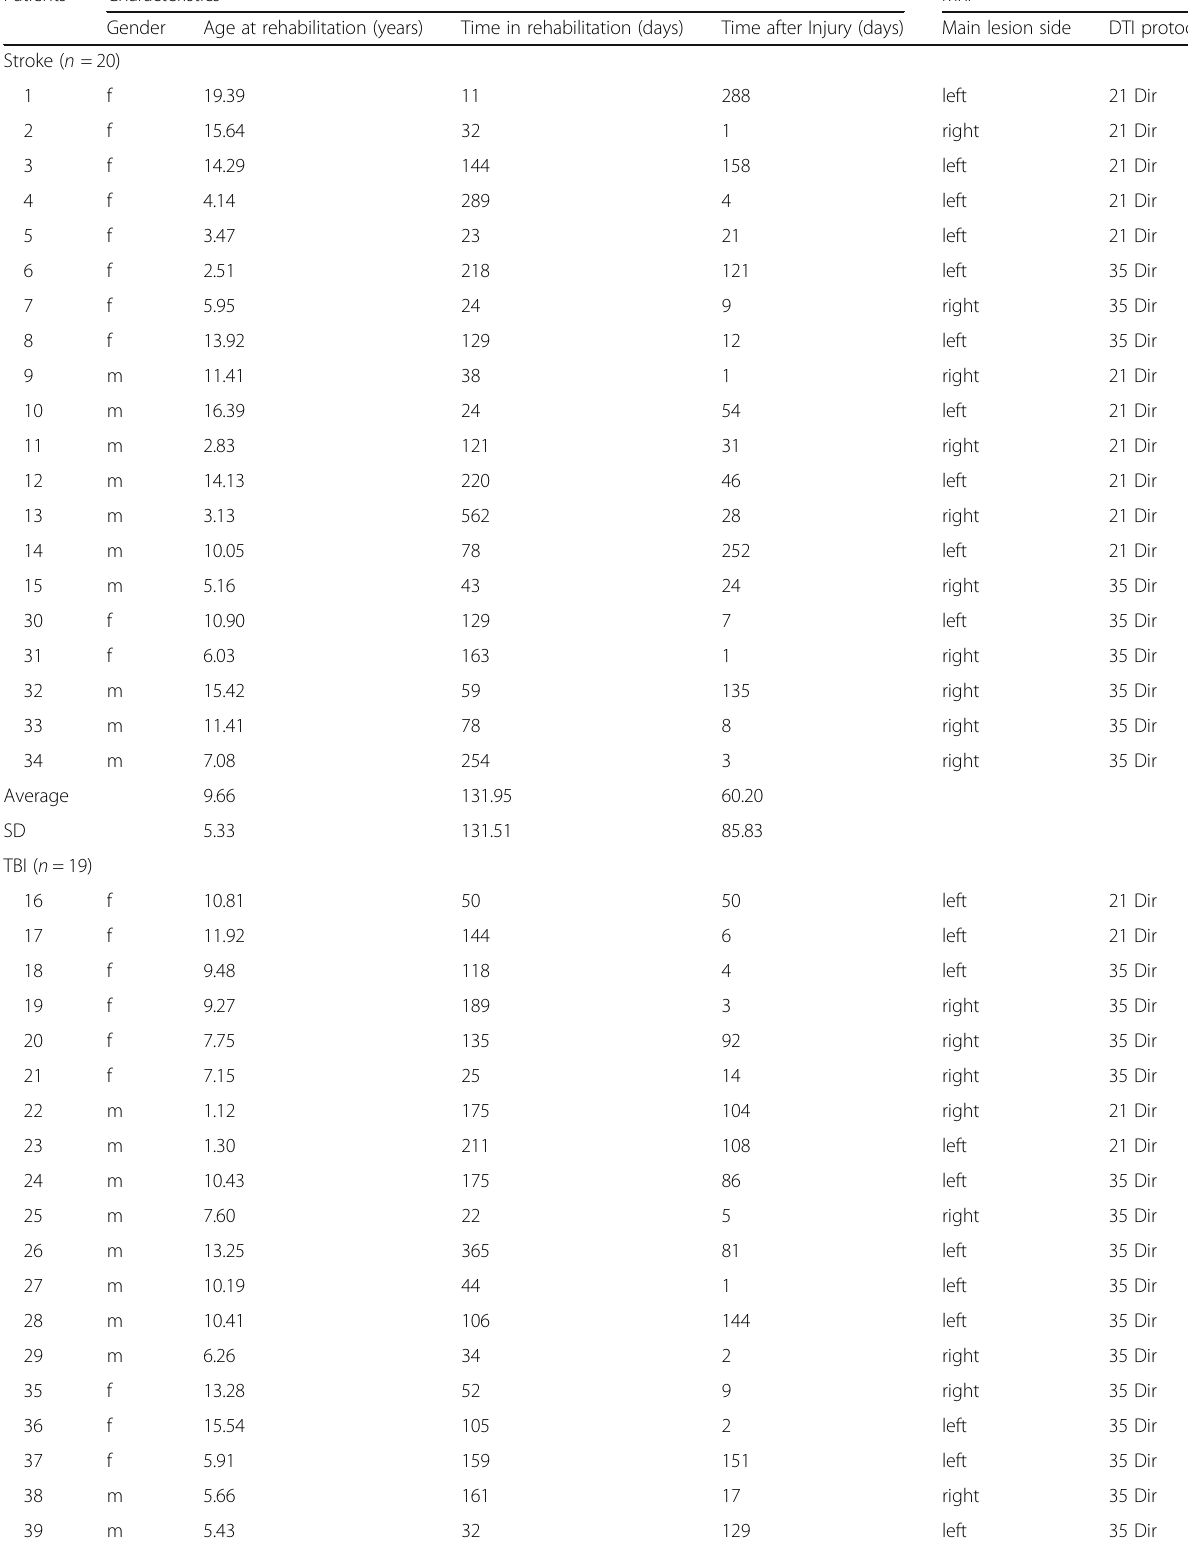
Table 1 Patients and diffusion tensor imaging characteristics